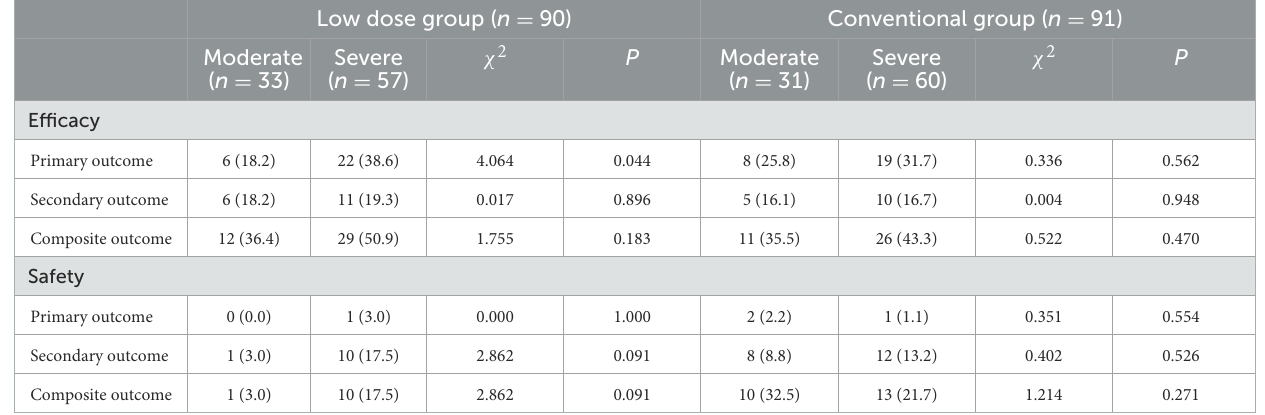
TABLE 5 Efficacy and safety outcomes of sICAS with moderate or severe stenosis ( n , %). Low dose group ( n =